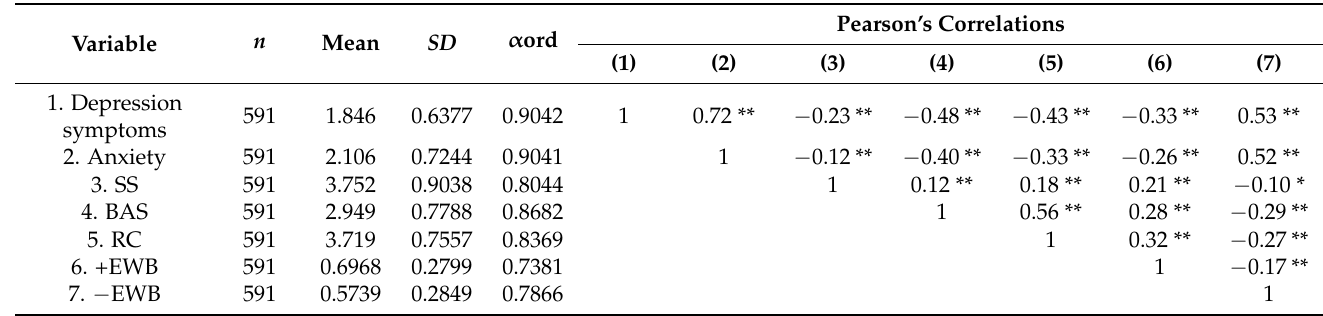
Table 1. Mean, standard deviation, internal consistency, and Pearson’s correlations for the variables under study.